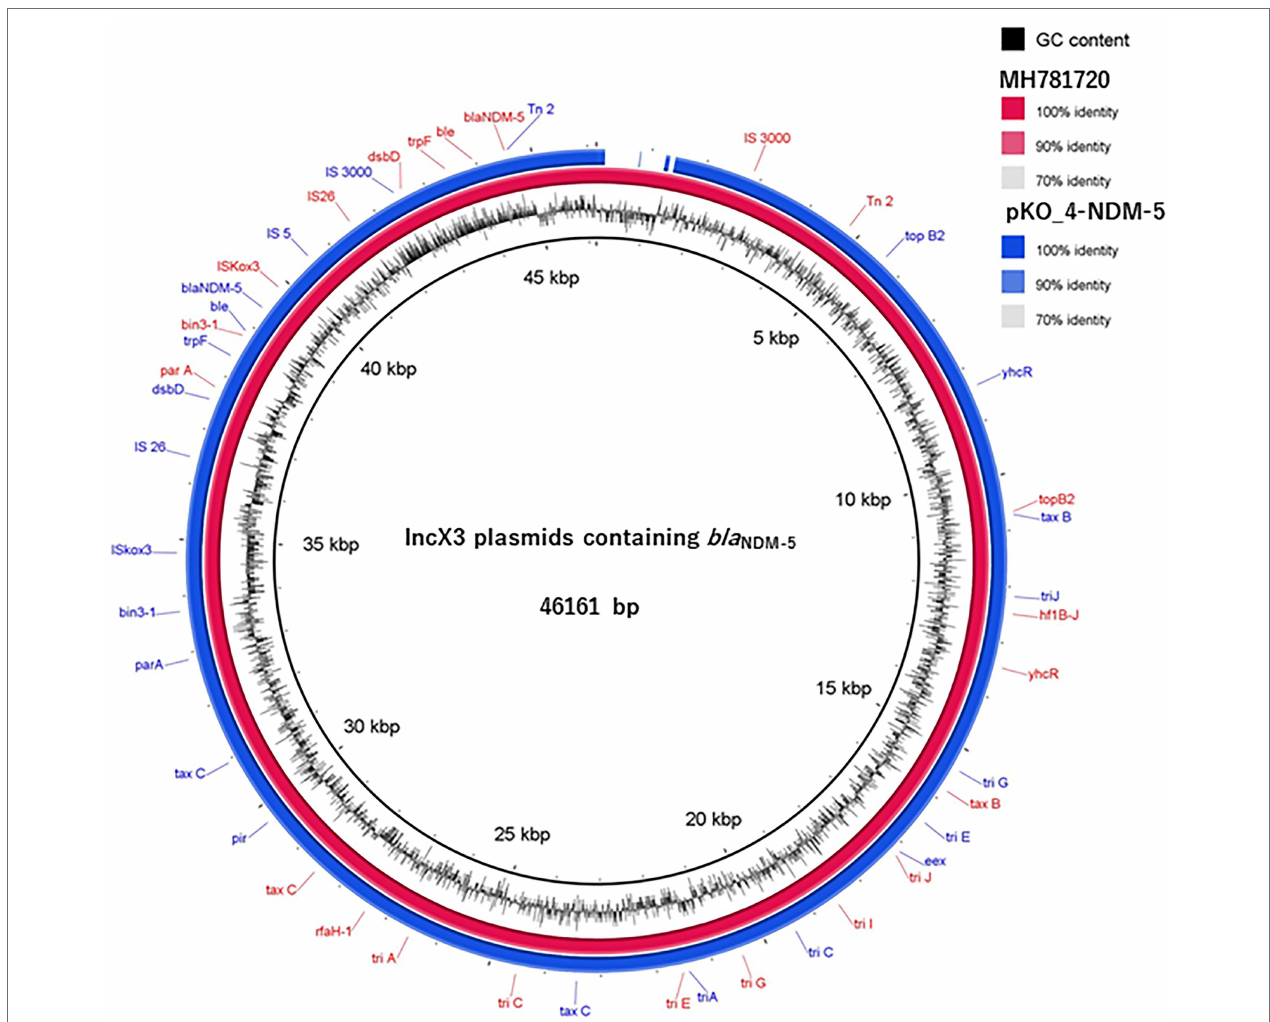
FIGURE 3 | A circular comparison of pKO_4-NDM-5 and MH781720, an IncX3- bla NDM-5 containing plasmid. The homology between these two plasmids is shown by the percentage identity in the figure legend, whereas the absence of or a similarity value of <70% is indicated on the circular map as a white